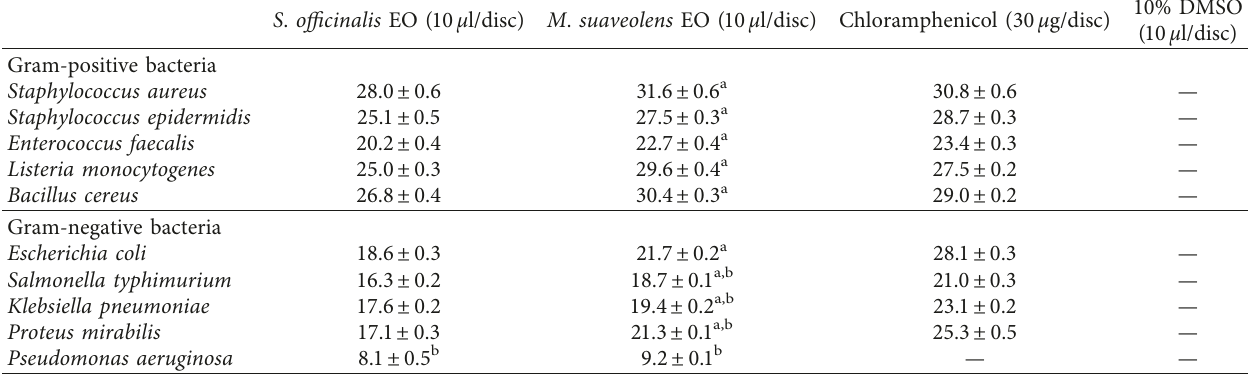
Table 3: In vitro antibacterial activities of the essential oils (EOs) of Salvia officinalis and Mentha suaveolens via the disc-diffusion method. Chloramphenicol and DMSO were used as a positive and negative control, respectively.